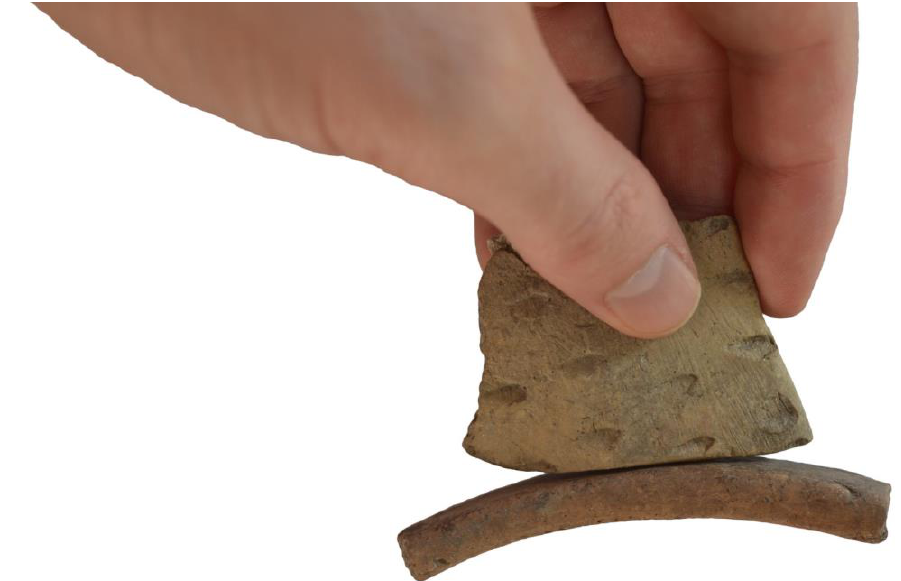
Figure 12. Illustration of how a re-used ceramic sherd smoother would be used.